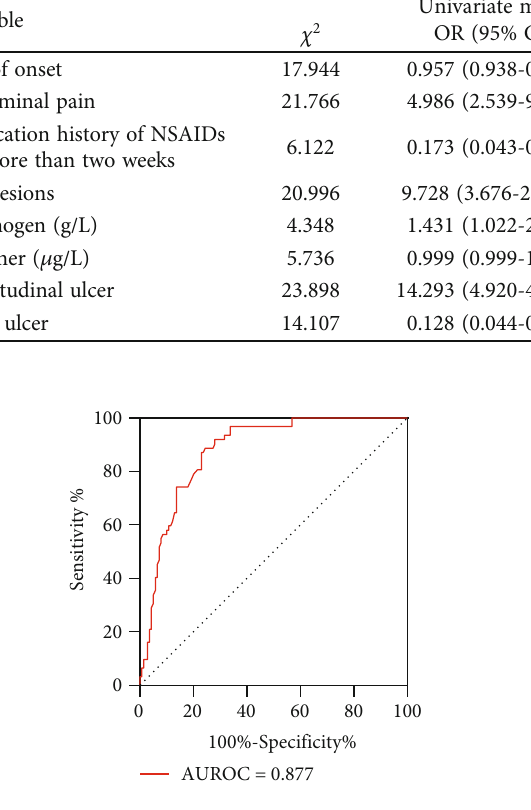
Figure 5: Receiver-operating characteristic (ROC) curve of ISBCD